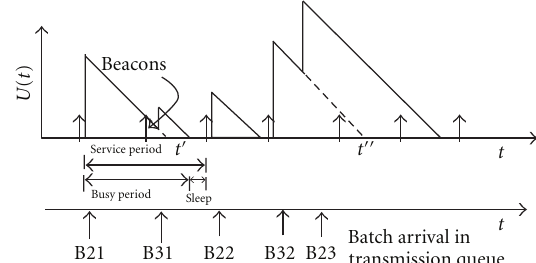
Figure 5: Batch arrival process in STA1 queue for a two peers. B21 denotes the first batch for STA2. Similarly B32 is the second batch for